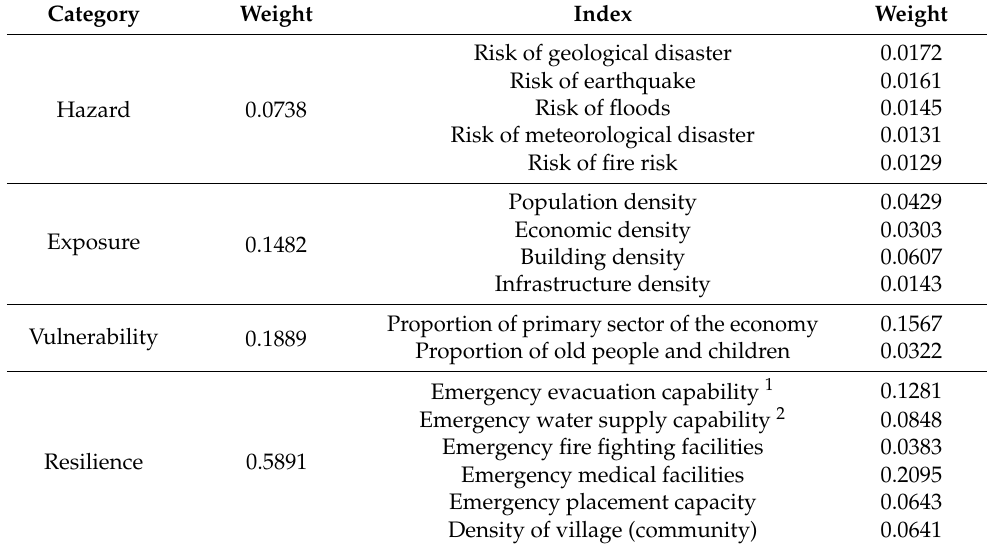
Table 1. Index system of multi-disaster integrated risk